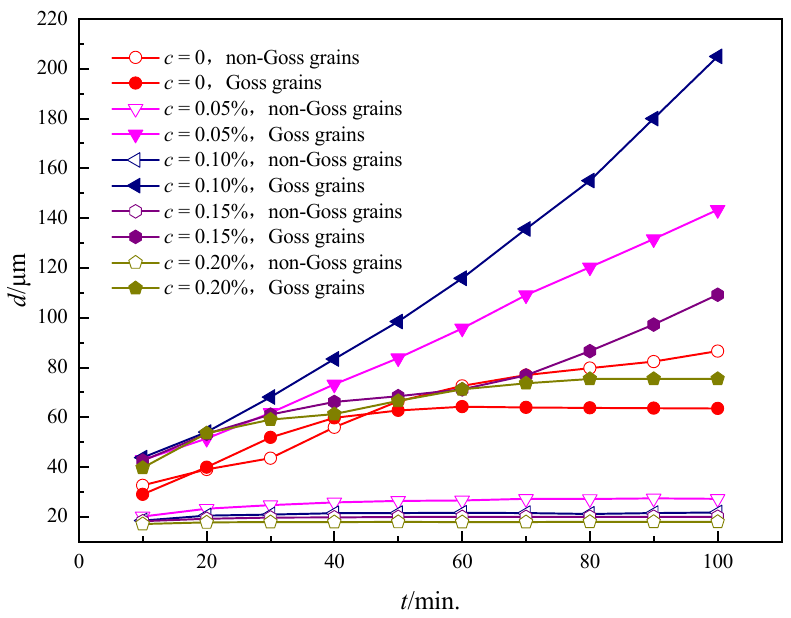
Figure 7. The kinetic curves for Goss and non-Goss grains under different particle contents where T = 1273 K and ω = 0.90.